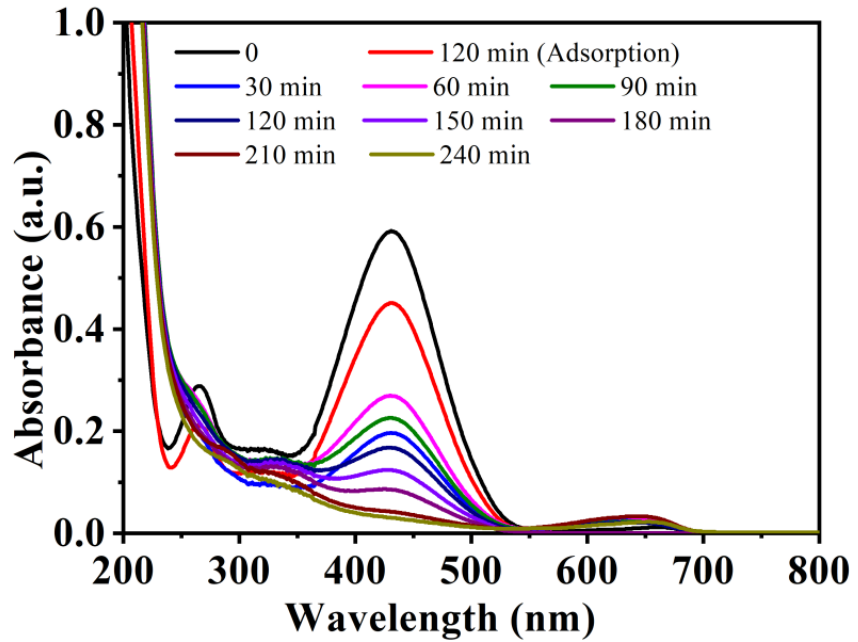
Figure 9. UV–Vis spectra of PR after 240 min of irradiation process by 30 W LED on the CuH–3.5 sample. Note: 250 mL of the 100 ppm PR solution, 0.2 g CuH–3.5 sample, 1.2 mL of 30% H 2 O 2 , solution diluted 10 times